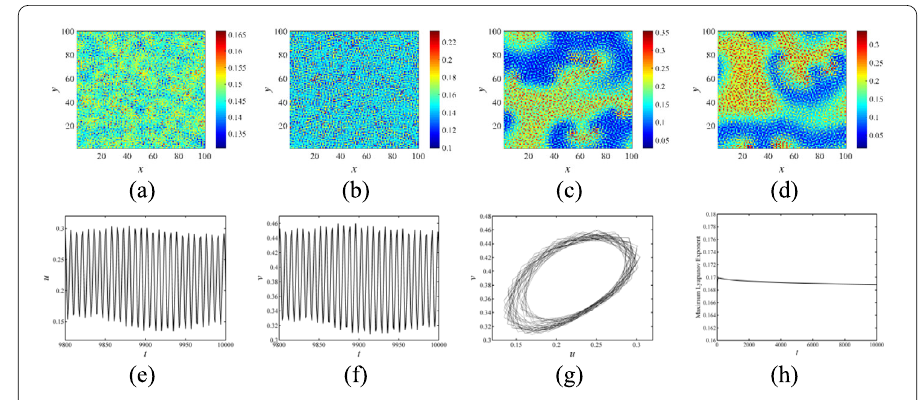
Figure 3 Self-organziation and nonlinear properties of a spiral-spot pattern. ( a )–( d ) Evolution of the prey pattern at transient times t = 10, t = 100, t = 1000, and t = 10,000, respectively; ( e )–( g ) wave diagrams and phase portrait of the prey and the predator in a random site of the predator and prey patterns; ( h ) maximum Lyapunov exponent diagram corresponding to the prey pattern. The parameter values are given as a = 1.1,